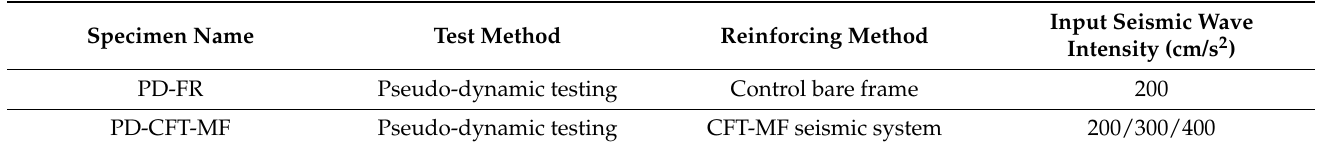
Figure 7. Shape of target building and target frame selected for pseudo-dynamic testing ( a ) front view and ( b ) top view. Table 3. Pseudo-dynamic testing specimens and applied